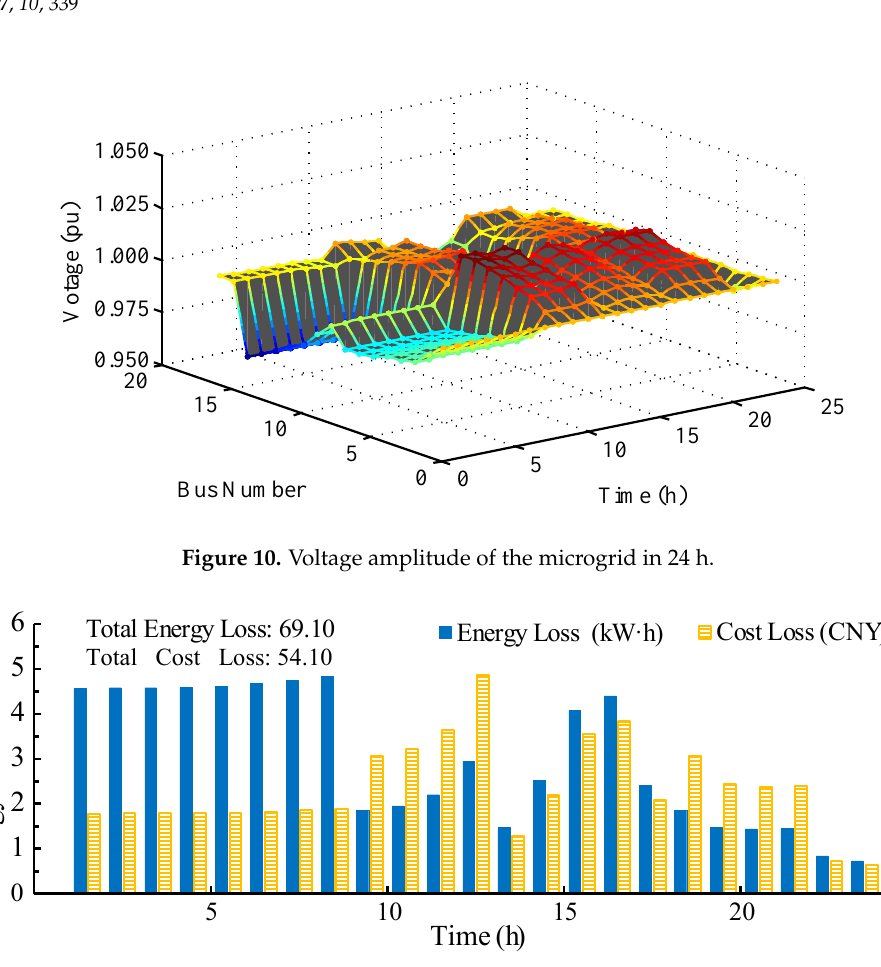
Figure 11. Energy and cost loss of the microgrid in 24 h.